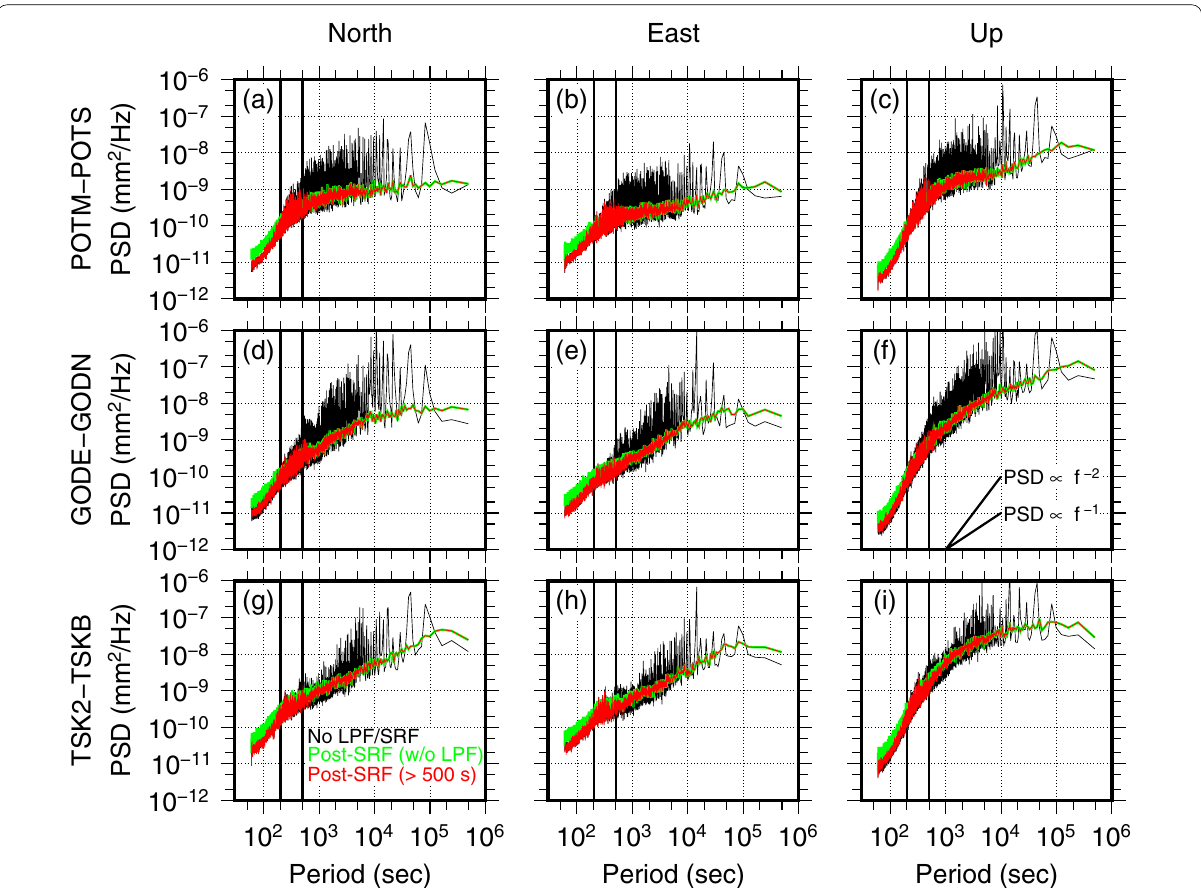
Fig. 9 Average of power spectral density (PSD) of each block of kinematic coordinates. a – c North ( a ), east ( b ), and up ( c ) PSD before (black) and after sidereal filtering (SRF) without (green) and with (red) low-pass filtering (LPF) to the sidereal filter. A cut-off period of the low-pass filter is 500-s. Two vertical thick lines indicate a period of 200 and 500 s. Solid slant lines indicate PSD of random-walk (PSD noises (PSD f − 1 ). d – f Same as a – c but for GODE-GODN. g – i Same as a–c but for ∝